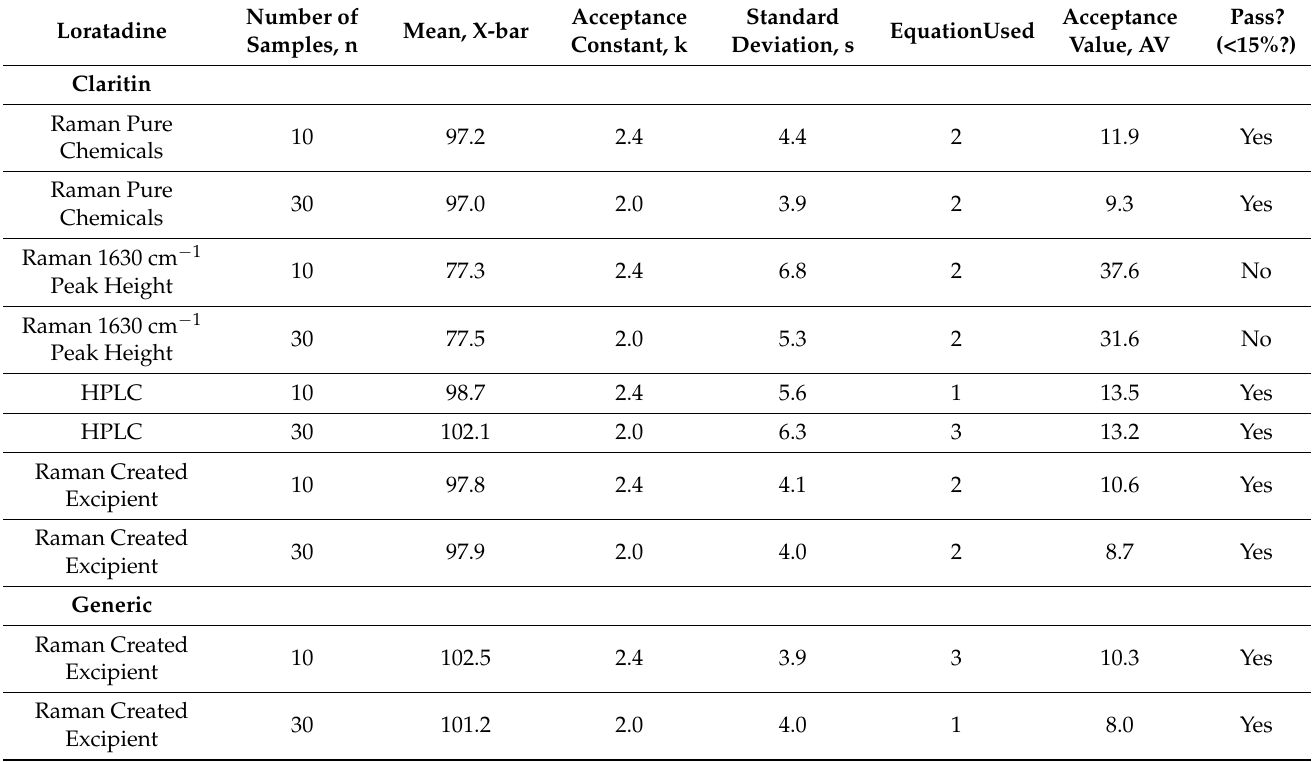
Table 1. Calculated Acceptance Values for 10 and 30 tablets each of Claritin and a generic product based on loratadine mass percents by HPLC, Raman chemical component analysis, and Raman created composite excipient